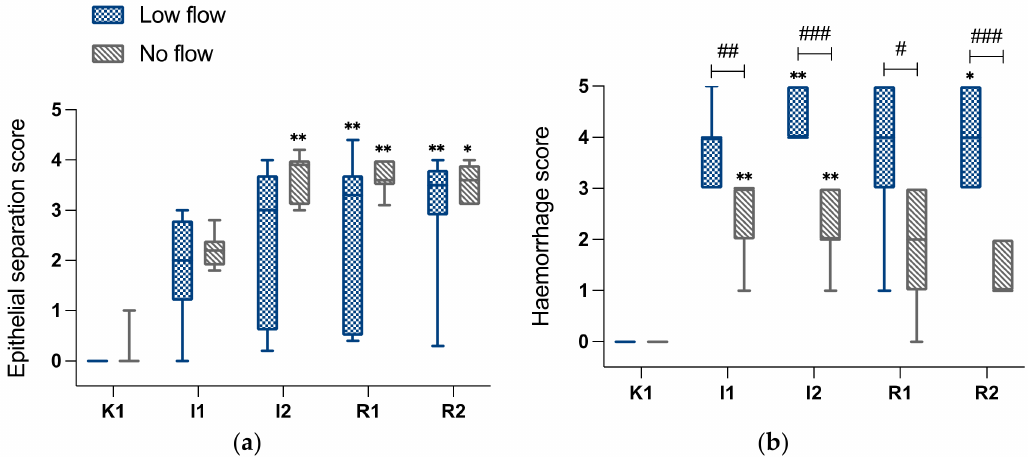
Figure 7. Box-plot diagrams of EPS ( a ) and mucosal HS ( b ) evaluated according to modified Chiu- score of the LF and NF group for the different intestinal samples. P, pre-ischaemia; I1, 60 min ischaemia; I2, 120 min ischaemia; R1, 60 min reperfusion; R2, 120 min reperfusion. Significant differences of the time points compared to pre-ischaemia are marked with an asterisk (* p < 0.05; ** p < 0.01), significant differences between the groups are indicated with a horizontal bar and accompanying hash (# p < 0.05; ## p < 0.01; ### p <